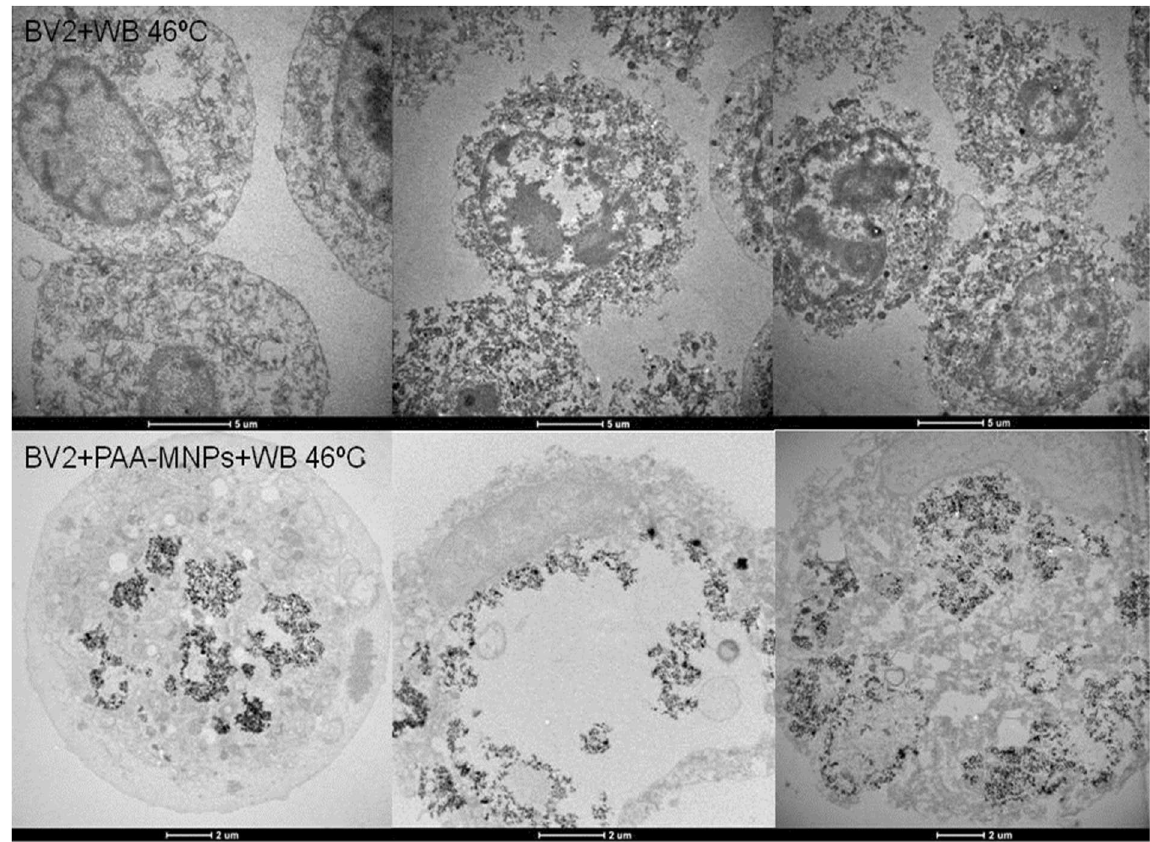
Figure 9. TEM images of BV2 cells after 30 min of water bath hyperthermia at 46 °C. TEM images of BV2 cells containing 100 µ g/ml of PAA-MNPs after 30 min of water bath hyperthermia at 46